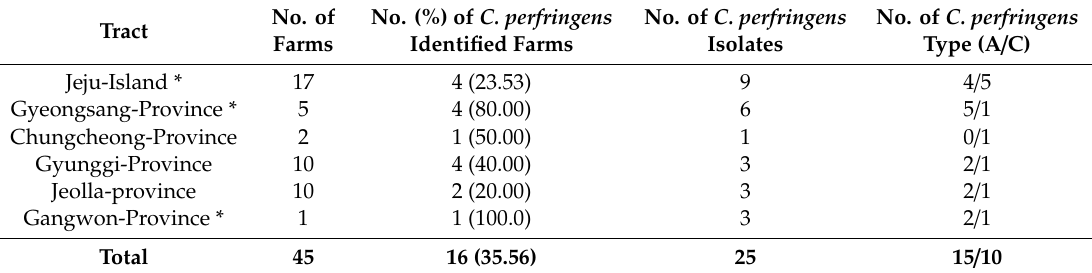
Table 1. Clostridium perfringens identified farms and